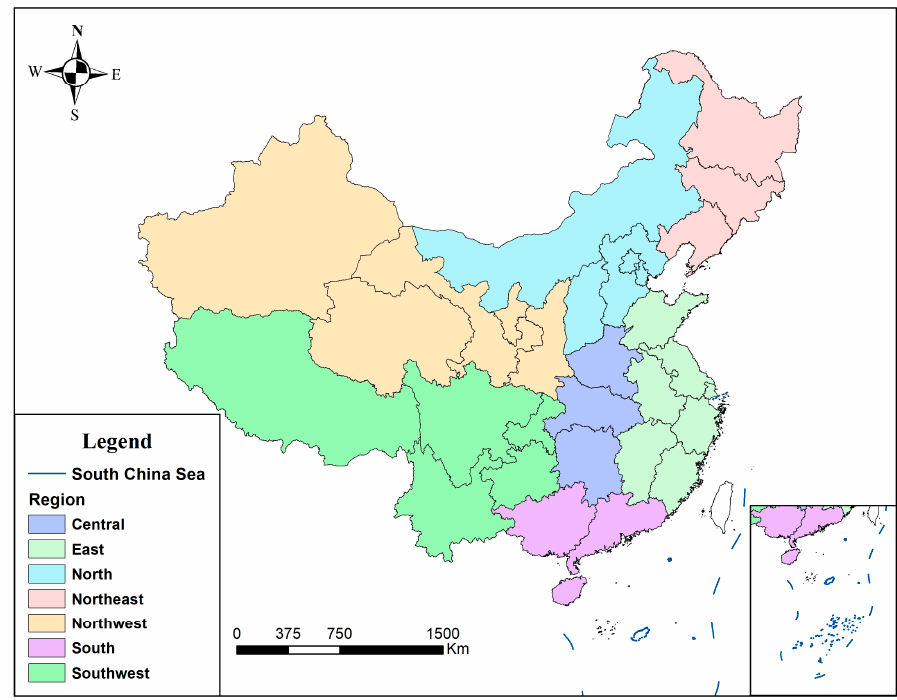
Figure 1. Regional division map of the study area.